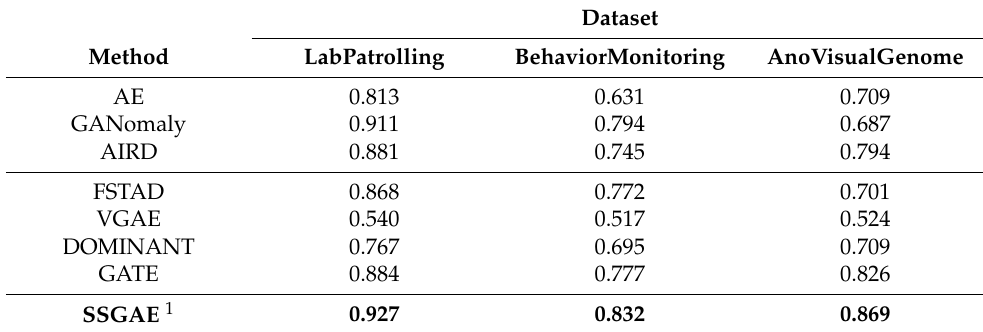
Table 2. Performance of SSGAE compared with the baseline methods.